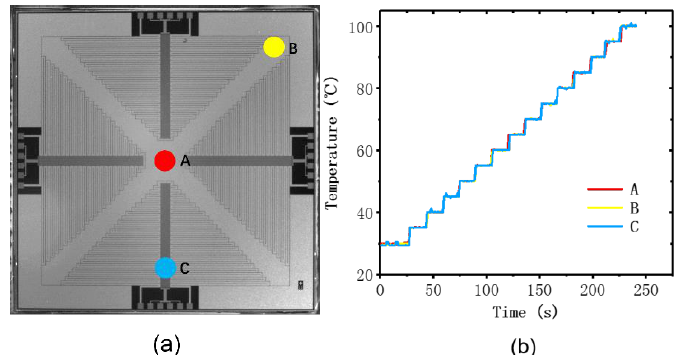
Figure 8. Heating uniformity experiment by monitoring three places on the PCR thermal control chip. ( a ) The positions at which the temperature was monitored: in the middle (red, A) and at the edges (yellow and blue, B and C). ( b ) The temperature traces of the three monitoring points measured by PT100.